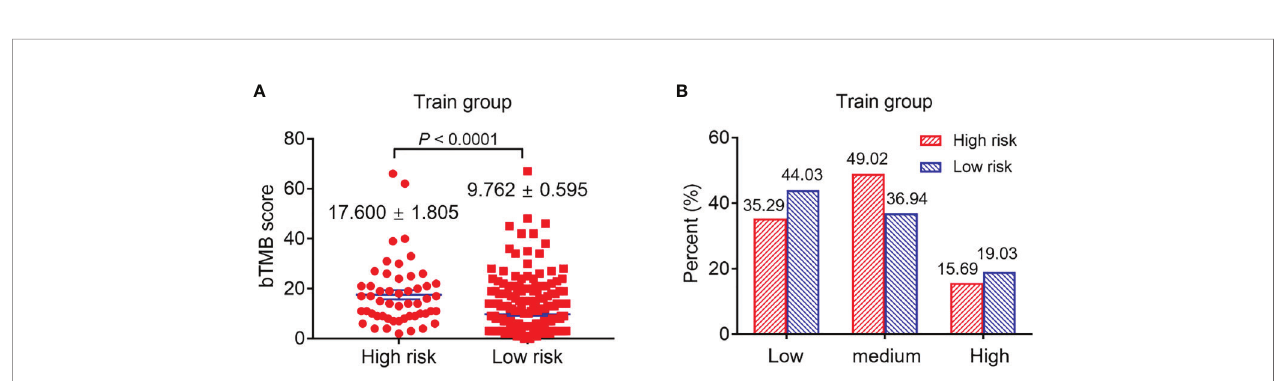
FIGURE 3 | The difference of bTMB score and PDL1 expression of patients with high and low risk. (A) The difference of bTMB score of patients with high and low risk ( P < 0.0001). (B) The difference of PDL1 expression of patients with high and low risk.